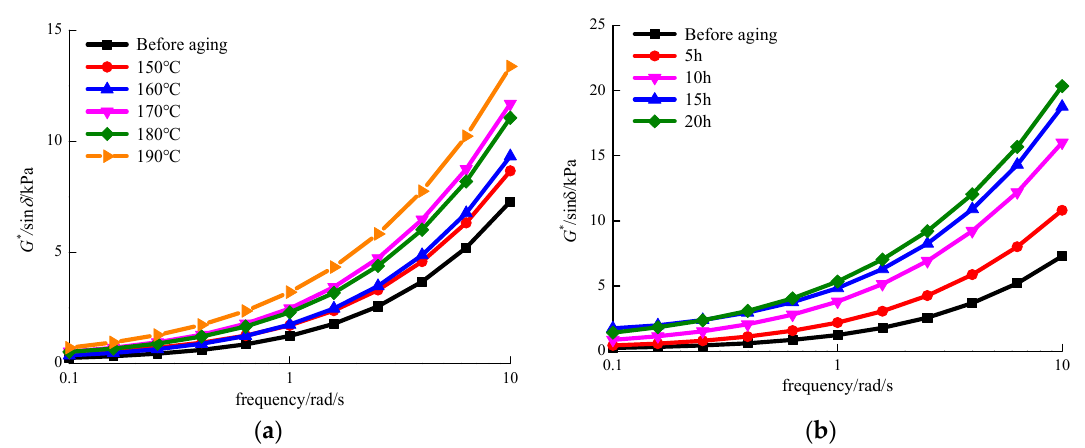
Figure 6. G */sin δ values of MACRMA at different aging condition ( a ) aging temperature and ( b ) aging time.